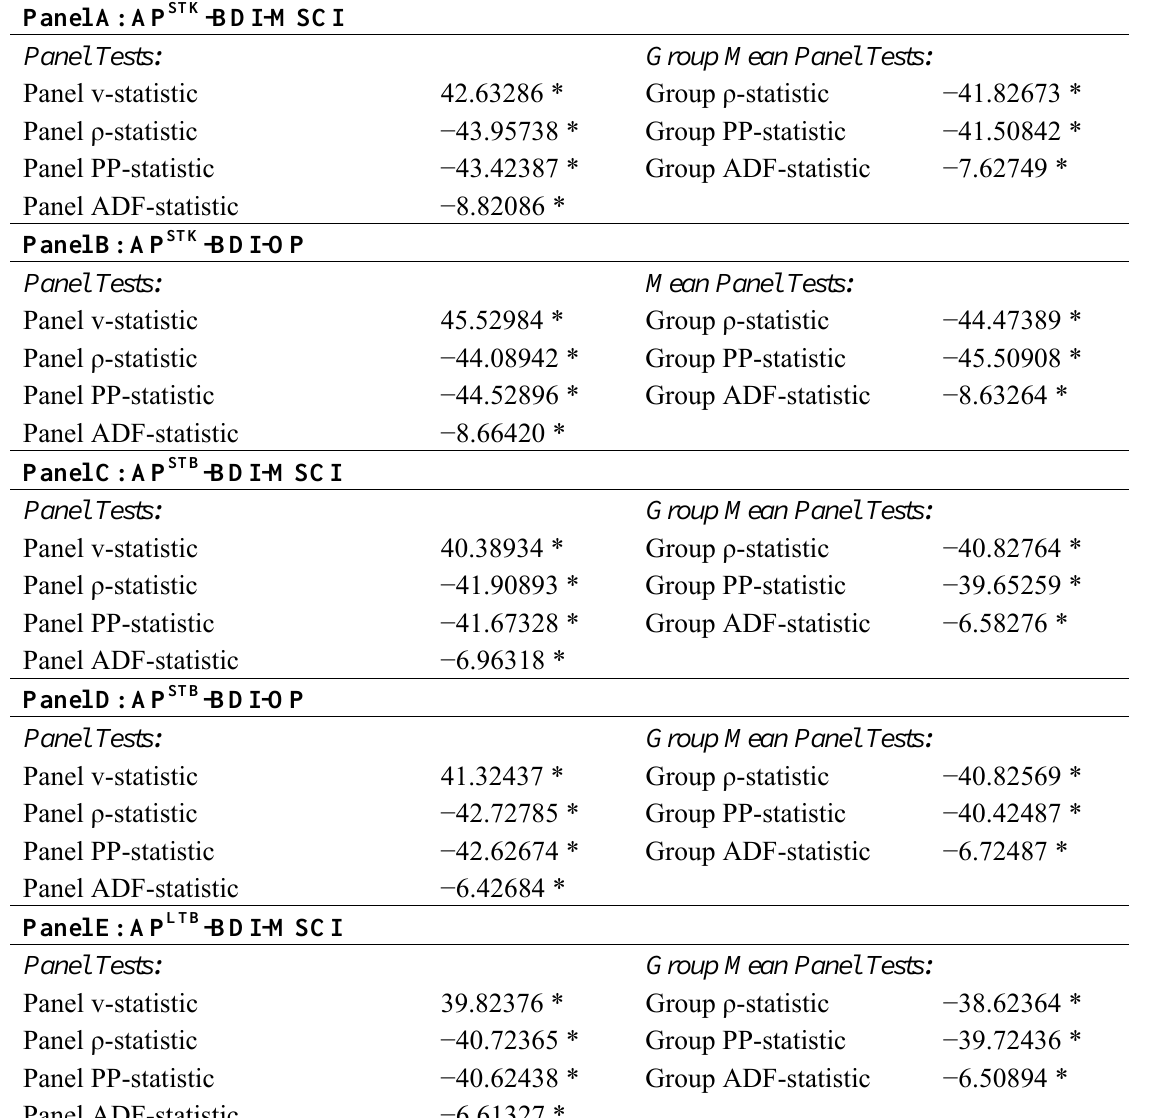
Table 5. Extended panel cointegration